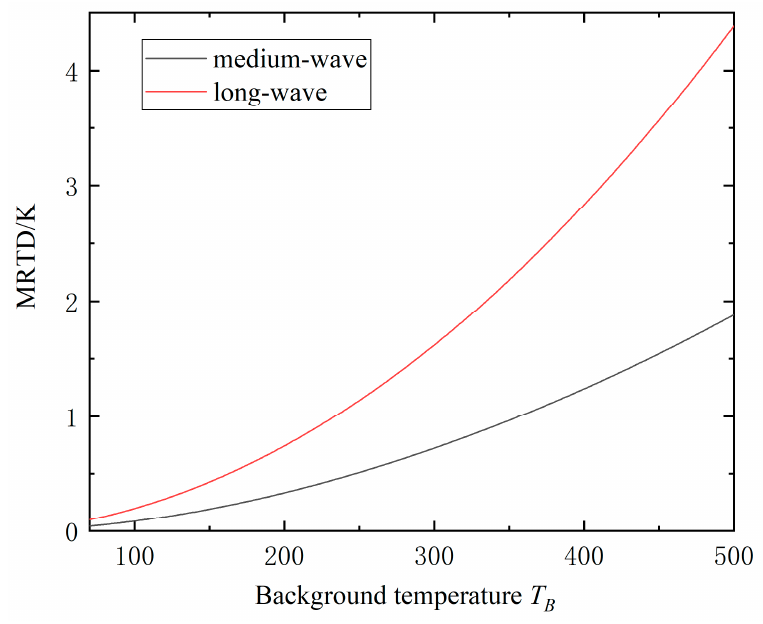
Figure 8. Relationship between background temperature T B and MRTD (IPD). As shown in Figure 7, MRTD increases with increasing spatial frequency, which means that when the target to be measured has a certain temperature difference, the higher the spatial frequency, the lower the temperature resolution of the system, which means that the target to be measured is more difficult to be